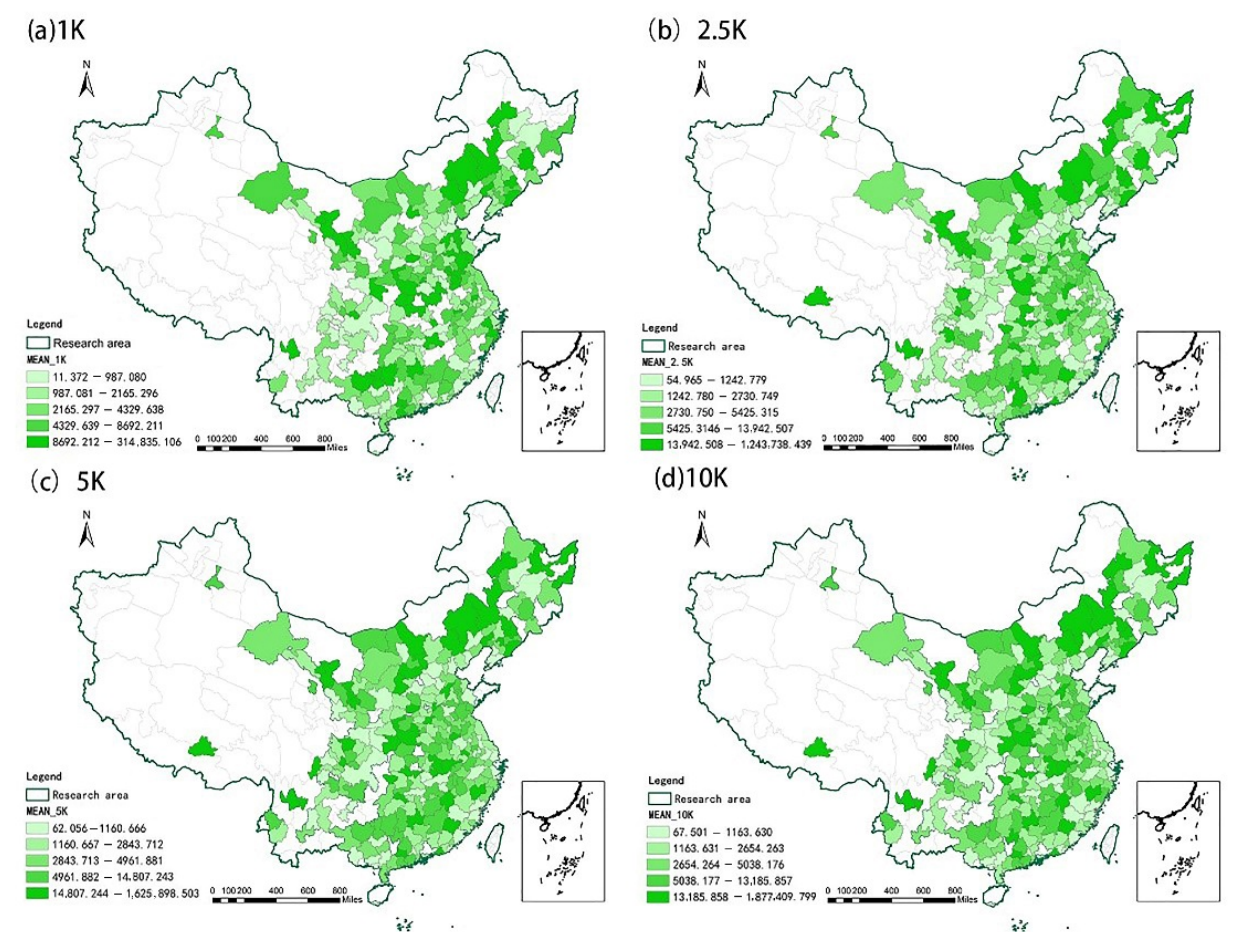
Figure 2. Changes in the spatial accessibility in the study area when ( a ) d 0 = 1 km; ( b ) d 0 = 2.5 km; ( c ) d 0 = 5 km; and ( d ) d 0 = 10 km.